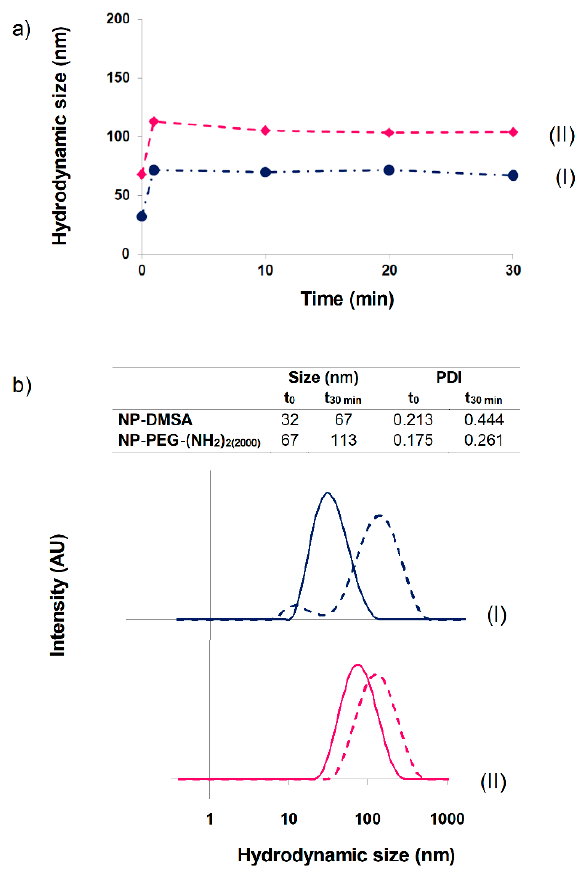
Figure 2. ( a ) Nanoparticle hydrodynamic size evolution up to 30 min in presence of plasma. ( b ) Hydrodynamic sizes of nanoparticles in aqueous suspension (solid line) and after 30 min of incubation with plasma (dotted line). (I) NP-DMSA, (II) NP-PEG-(NH 2 ) 2(2000) .